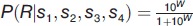
Probabilistic classification task.
A, After the network attained fixation, we presented four shapes in a random order at four locations. The shapes s
1,⋯,s
4 cued a saccade to the red or green target: their location varied randomly across trials. Reward was assigned to the red target with probability P(R|s1,s2,s3,s4)=10W1+10W, with W=∑i=14wi, and to the green target otherwise. Inset shows weights wi associated with cues si. B, The sensory layer had units for the fixation point, for the colors of the targets on each side of the screen and there was a set of units for the symbols at each of the four retinotopic locations. C, Activity of two context sensitive memory units and Q-value units (bottom) in a trial where four shield-shaped symbols were presented to a trained network. The green target is the optimal choice. F: fixation mark onset; D: memory delay; G: fixation mark offset (‘Go’-signal).